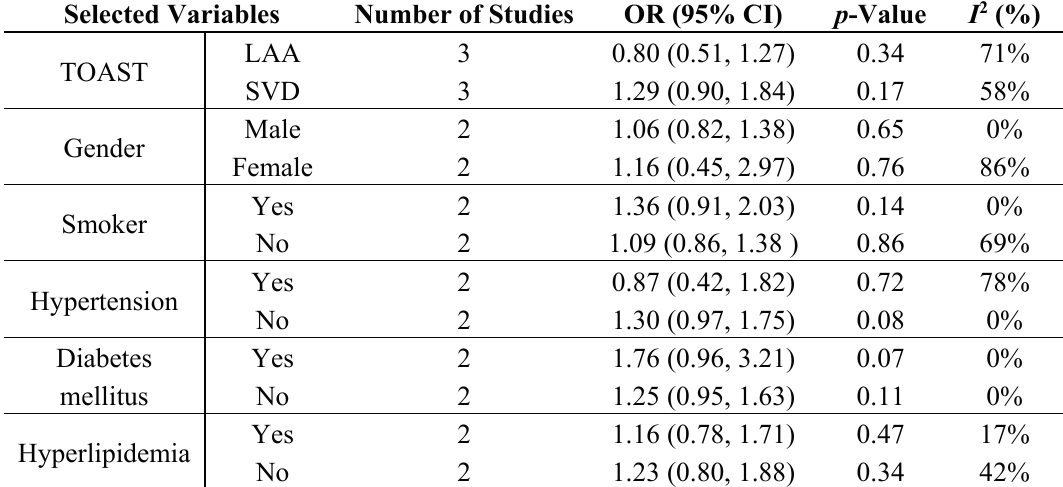
Table 3. Stratified effects of miR-146a (rs2910164) on ischemic stroke risk under dominant genetic model (GG/GC vs .